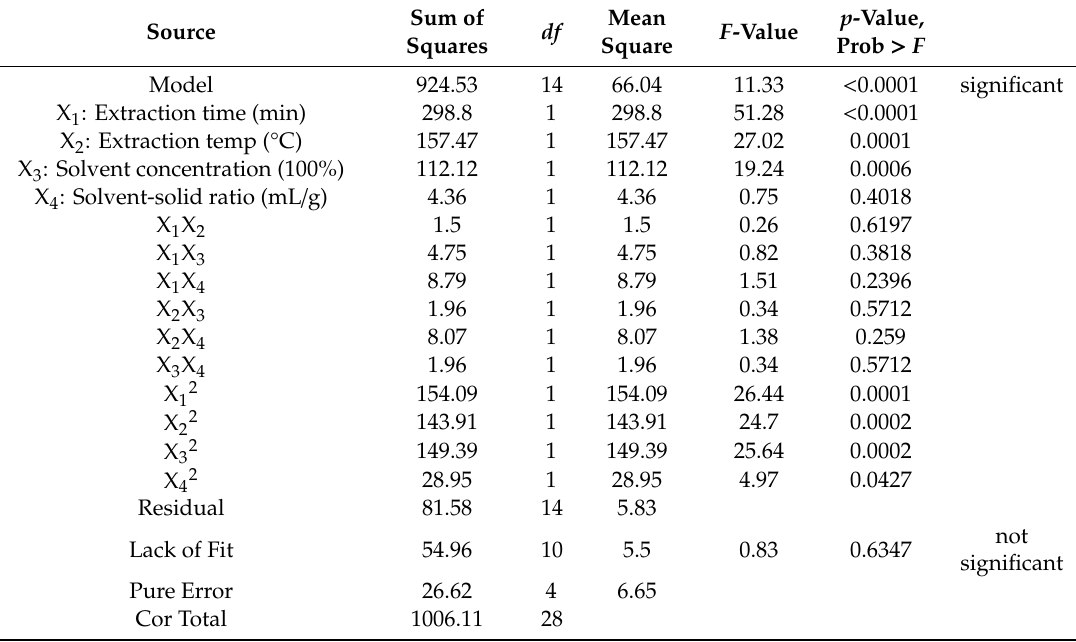
p -Value, Mean Sum of F -Value df Prob > F Square Squares